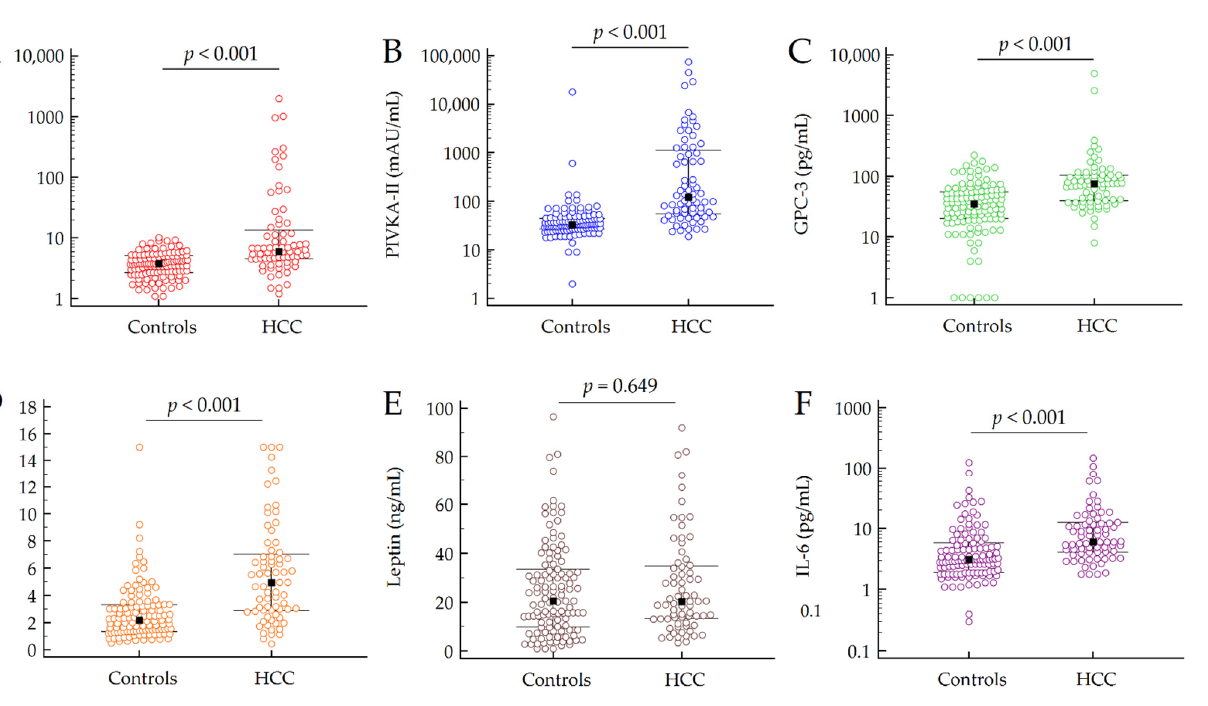
Figure 1. Median values of AFP ( A ), PIVKA-II ( B ), GPC-3 ( C ), adiponectin ( D ), leptin ( E ) and IL-6 ( F ) in patients with and without HCC. P -values were calculated by Mann–Whitney test. Black squares and error bars represent, respectively, the median value and the IQR in each group of patients. The values of AFP, PIVKA-II, GPC-3 and IL-6 are depicted in Log scale due to data skewness. Abbreviations: alpha-fetoprotein (AFP), glypican 3 (GPC3), hepatocellular carcinoma (HCC) and interleukin-6 (IL-6).